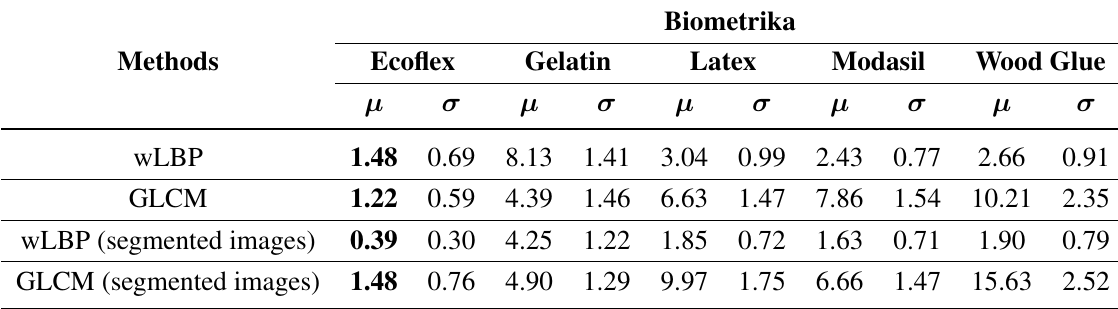
Table 2. Average Classification Error Rate (ACER) for each material of the Biometrika dataset, study 1 (ACER in % ).